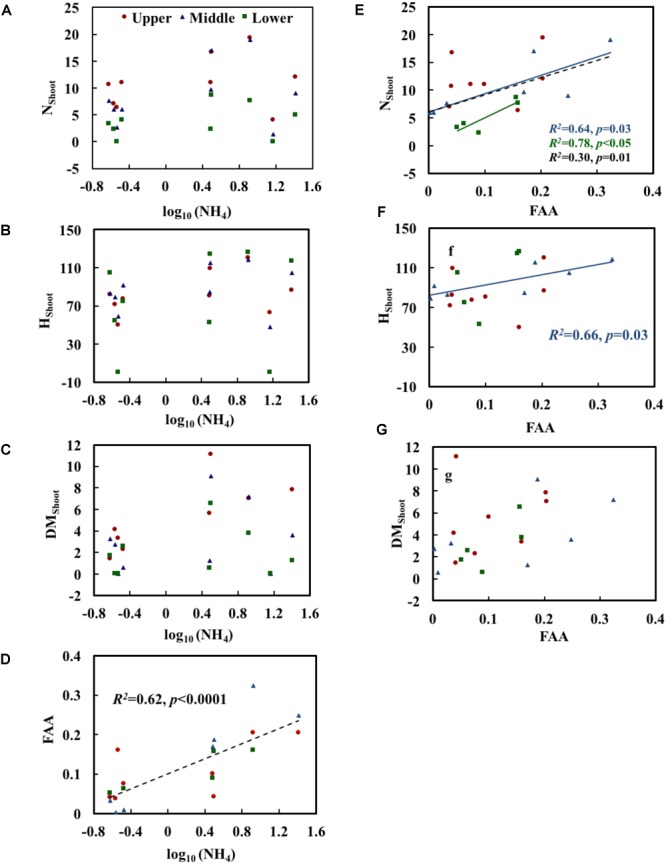
Relationships of NH4 (the measured concentration of total ammonium, including both NH3 and NH4+) with the morphological characteristics (A–C) and free amino acids (FAA) (D) of Potamogeton crispus and FAA (E–G) with morphological characteristics. Upper, middle, and lower represent the layer at 0.4, 0.8, and 1.2 m below the water surface. The dotted line shows significant relationships of pooled data from all depths (n = 9). The red, blue, and black R2 and p correspond to the red, blue, and black line, respectively.